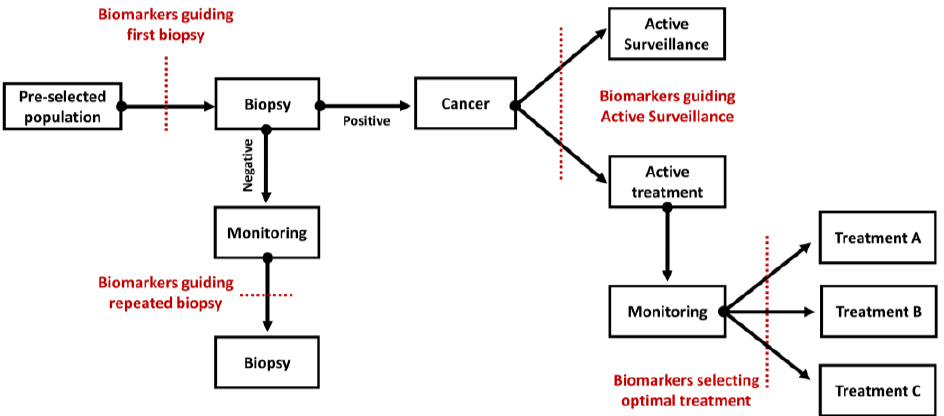
Figure 1. Schematic outline presenting the key elements of routine clinical practice in the management of patients with prostate cancer. The context of use for novel biomarkers is indicated in each case.